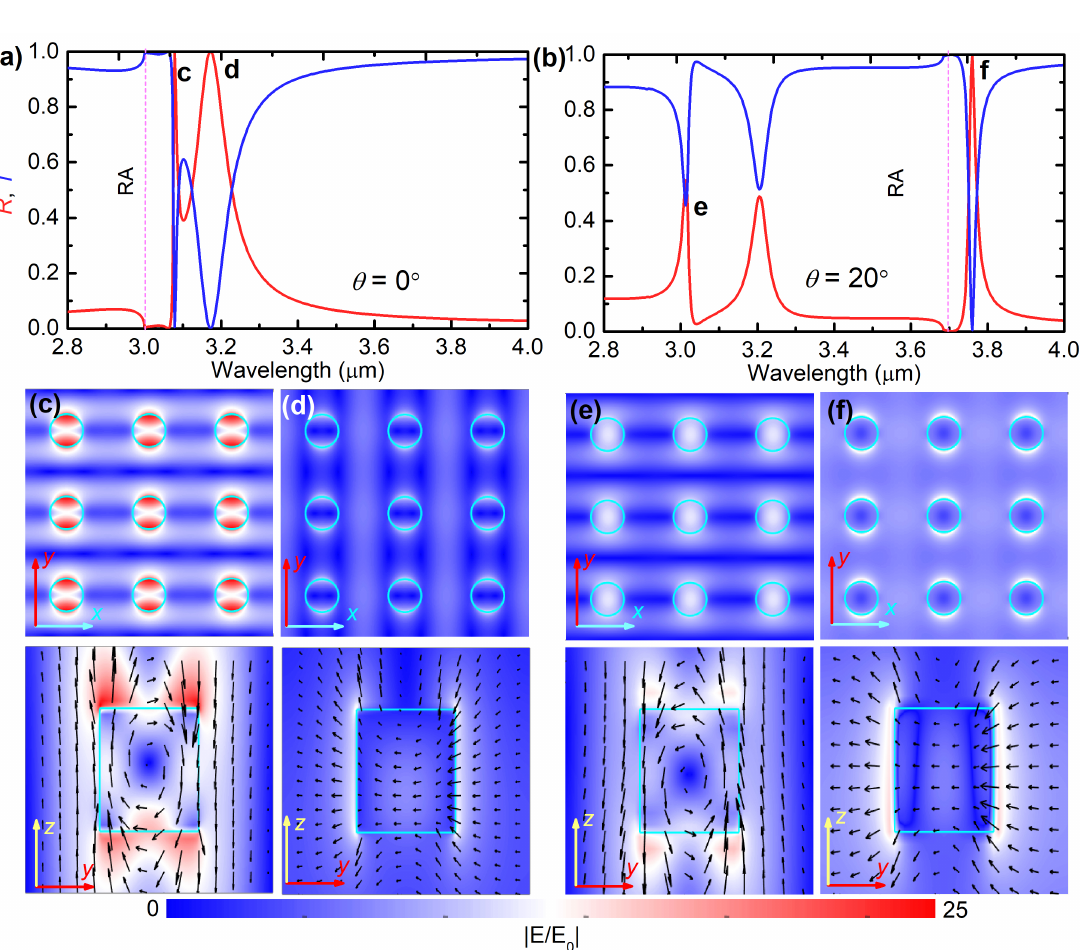
Figure 3. ( a , b ) Simulated reflectance (red) and transmittance (blue) spectra for TE-polarized incident light at ( a ) normal incidence ( θ = 0 ◦ ) and ( b ) oblique incidence of angle θ = 20 ◦ . Vertical pink dashed lines represent the ( − 1,0 ) order RA wavelengths. ( c , d ) near-field electric field distributions normalized to the incident field E 0 , | E / E 0 | showing the xy - and yz -planes intersecting the nanoparticle at its center, for ( c ) λ = 3.081 µm and ( d ) λ = 3.171 µm at θ = 0 ◦ , and ( e ) λ = 3.013 µm and ( f ) λ = 3.759 µm at θ = 20 ◦ . Color scale represents the electric field intensity, and arrows indicate the electric field